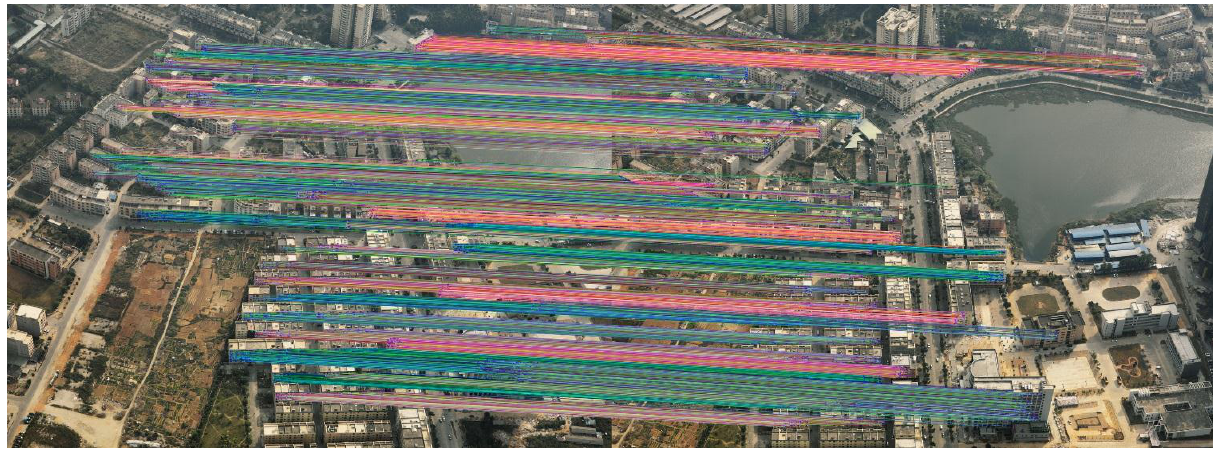
Figure 19. The final results of matching X-corners connected by lines.